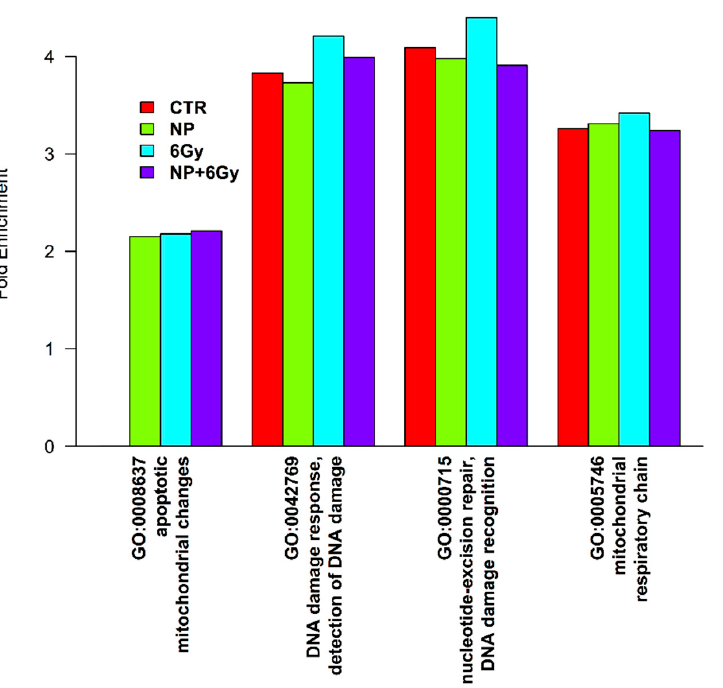
Figure 6. Gene Ontology analysis of the identified proteins. Fold enrichment, relative to the human proteome background, of GO terms related to DNA damage response and mitochondrial changes for all four conditions analyzed: control sample (CTR), treated with nanoparticles (NP), irradiated (6 Gy) and treated with nanoparticles and irradiated (NP + 6Gy).